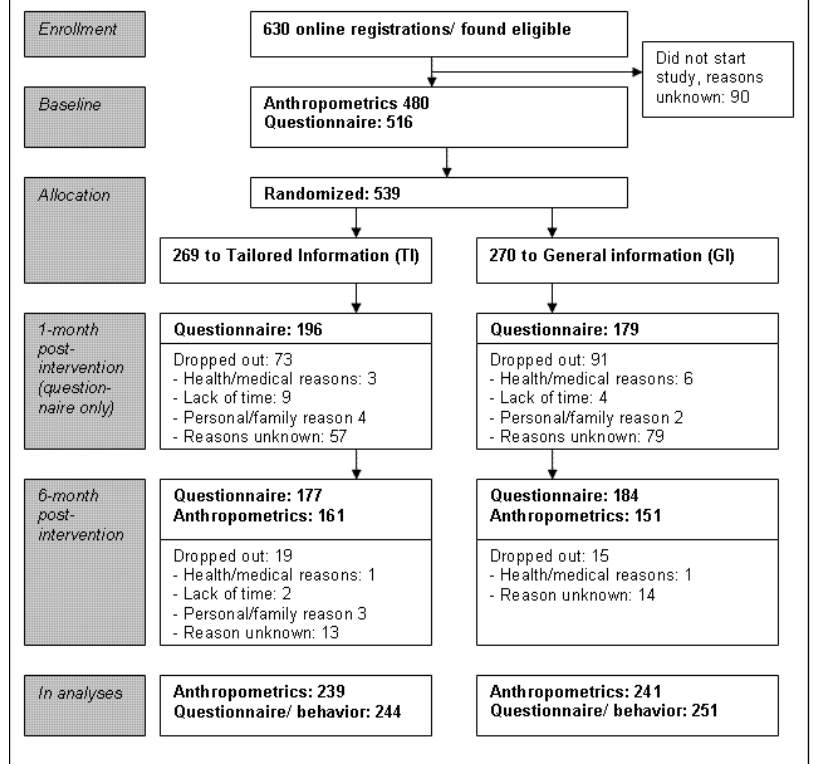
Figure 1. Participant flow for the GRIPP study.